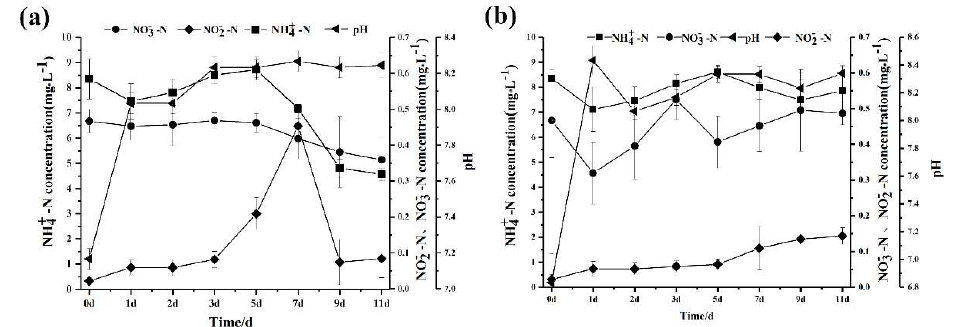
Figure 5. The nitrogen removal performance by strain SC16 in aquaculture water (( a ): the treatment group; ( b ): the control group). group; ( b ): the control